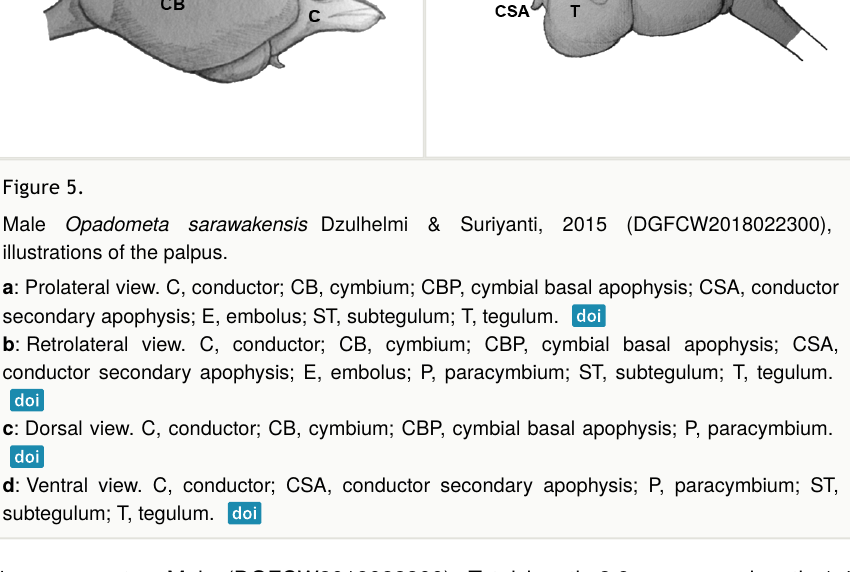
Measurements: Male (DGFCW2018022300): Total length 2.8; carapace length 1.4, width 0.9; abdomen length 1.4, width 0.9, height 0.9. Female (DGFCW2018022300): Total length 6.2; carapace length 3.6, width 2.4; abdomen length 5.0, width 2.8, height 2.7. Female (DGFCW2018022402): Total length 8.1; carapace length 3.4, width 2.7; abdomen length 7.6, width 4.2, height 4.2. Female (DGFCW2018022611): Total length 5.0; carapace length 3.5, width 2.1; abdomen length 4.4, width 2.6, height 2.6.